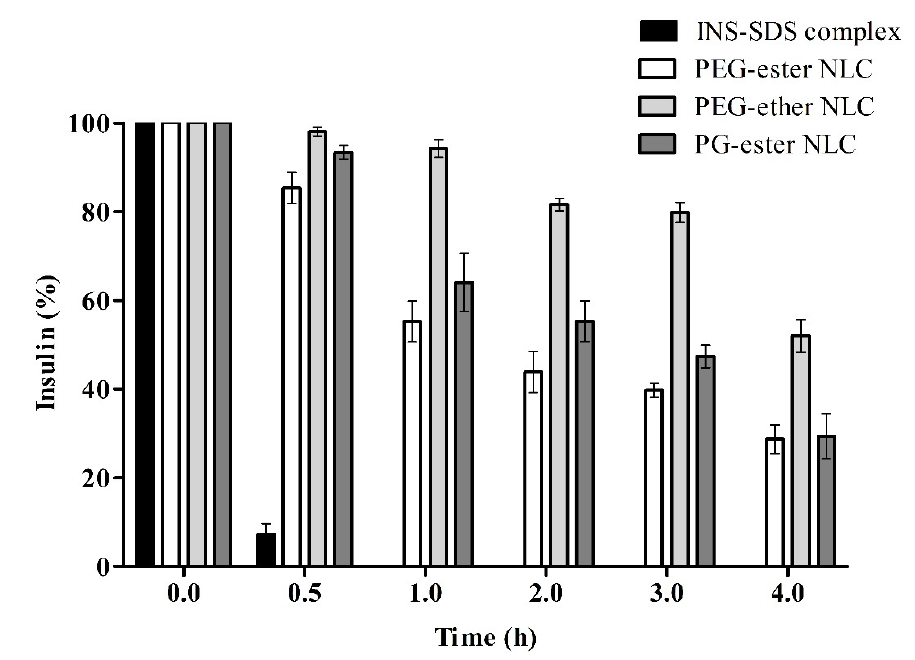
Figure 6. Remaining percentage of intact insulin in indicated formulations compared to the unformulated INS-SDS complex during degradation in SIF at 37 ◦ C and pH 6.8. At each time point, pancreatin activity in withdrawn aliquots was quenched by the addition of 0.01 M HCl. Data are shown as means ± SD ( n = 3).